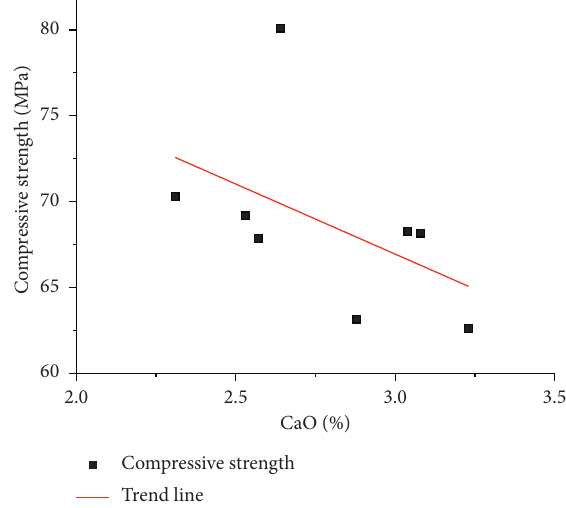
Figure 7: Relationship between mineral composition and peak strength in deep sandstone reservoirs.